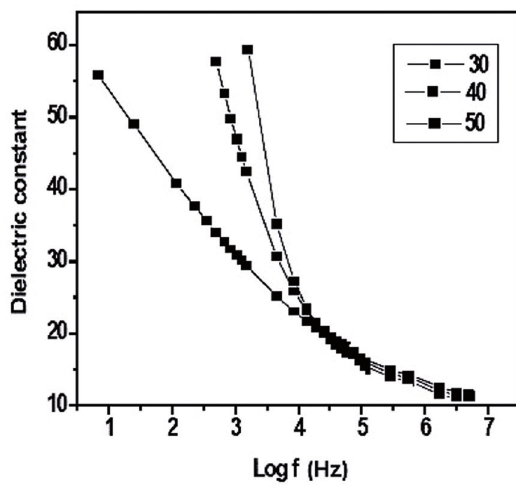
Figure 5: Dielectric constant of CoS thin film